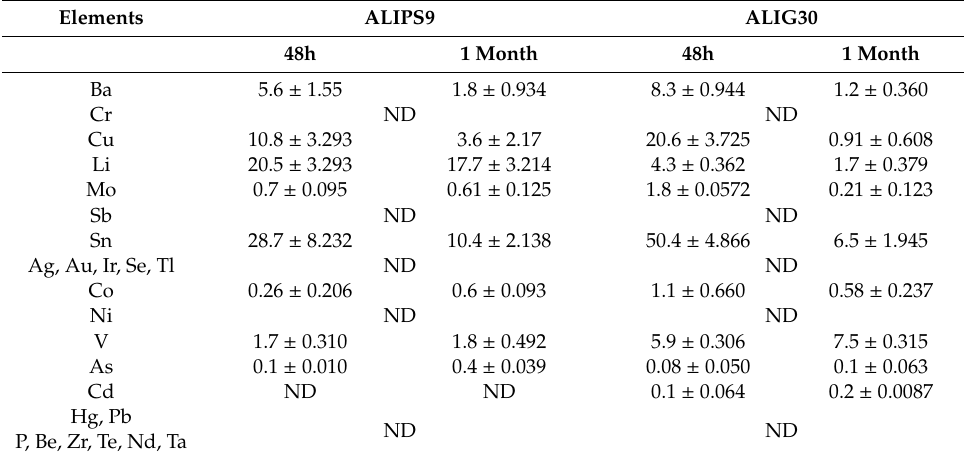
Table 3. Mobility of hazardous elements after Franz di ff usion cell tests. The concentrations are expressed in µ g / 100 g of hydrogel. Elements have been placed in the same order as in Table 2. Mean values ± s.e. ( n = 6). “ND” stands for “not